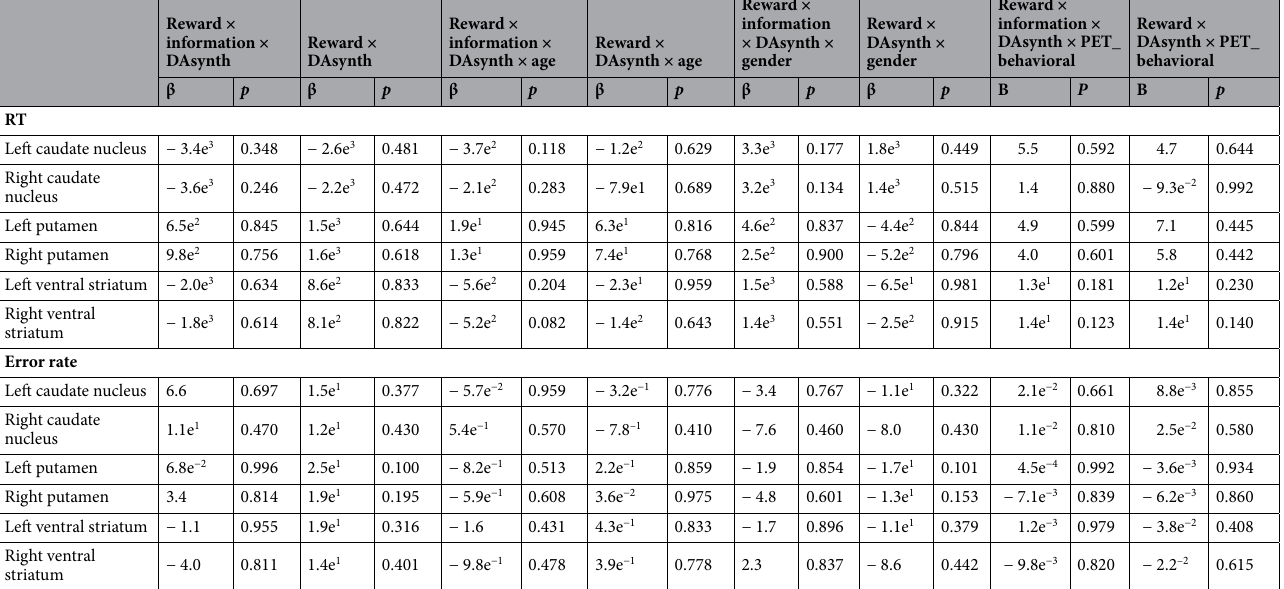
Table 3. Interaction effects obtained from multiple linear regression analyses assessing the effect of age, gender and time between the PET scan and behavioral testing (PET_behavioral) on motivational effects on Stroop interference (incongruent trials minus congruent trials) in terms of response times (RT) and error rates. Model: stroop_effect ~ DAsynth × reward × information × age + DAsynth × reward × information × gender + DAsynth × reward × information × PET_behavioral. Separate analysis for each ROI.